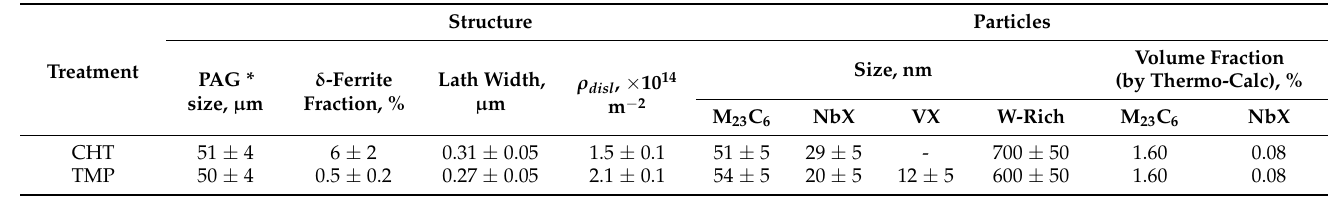
Table 8. Structural parameters of the 12CrNb0.003N steel after the CHT and TMP.